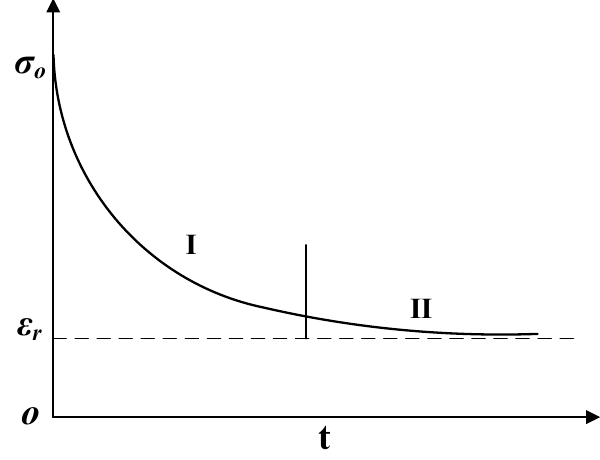
Figure 5. Typical stress relaxation curve.